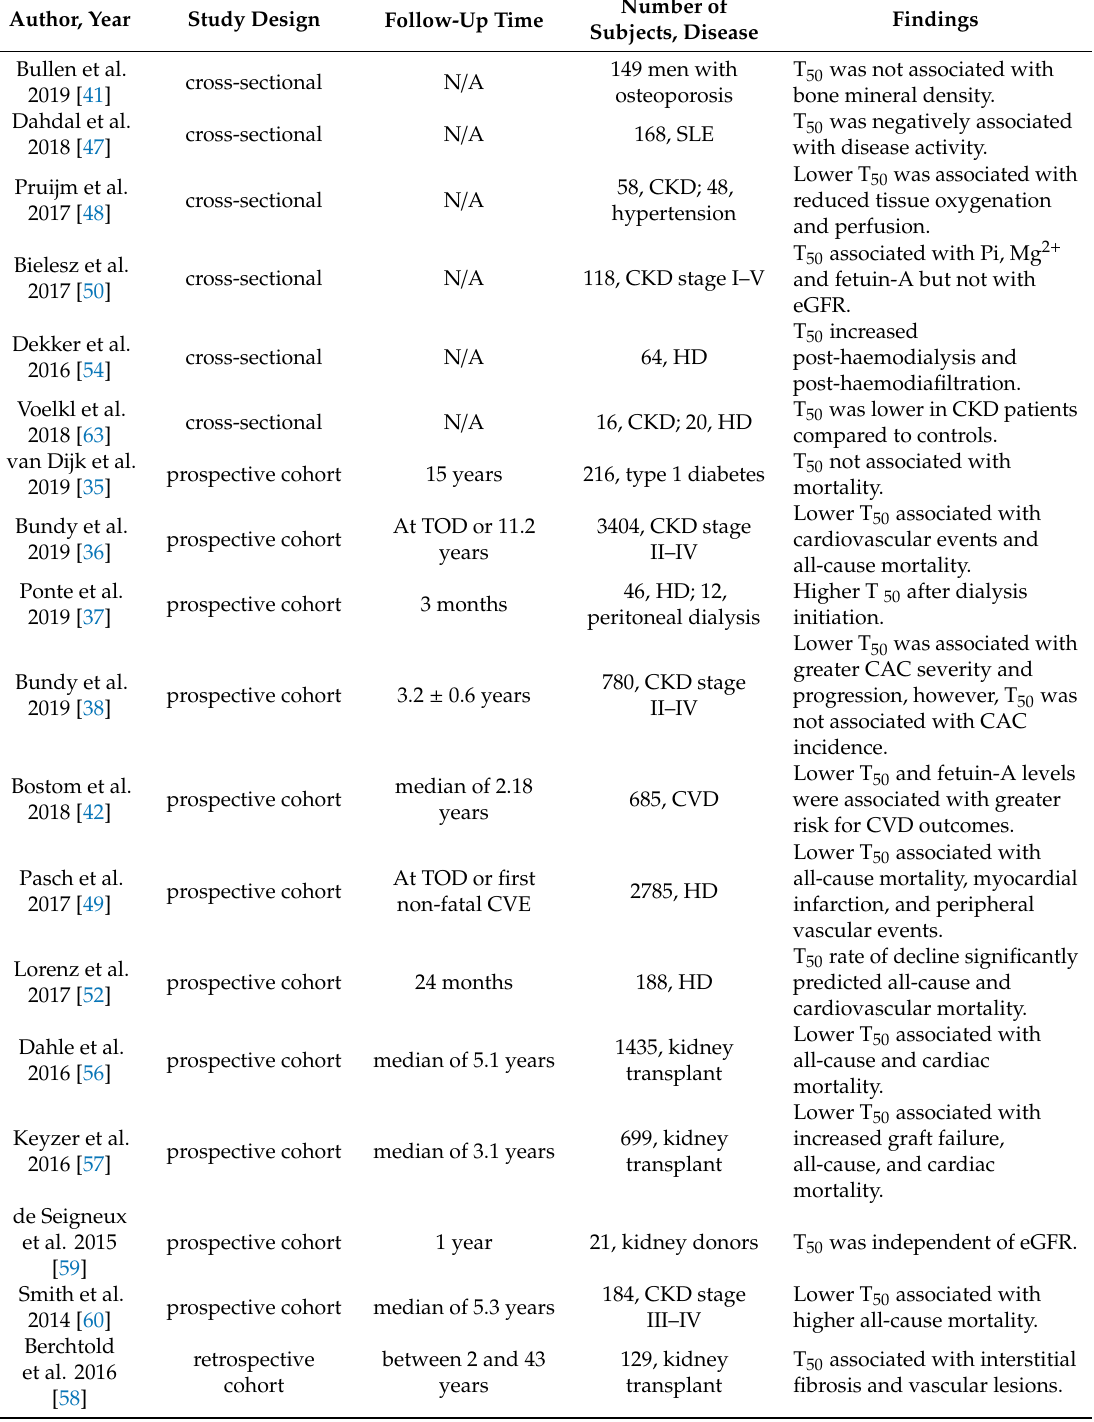
Table 3. Summary of 18 observational studies on T 50 and health